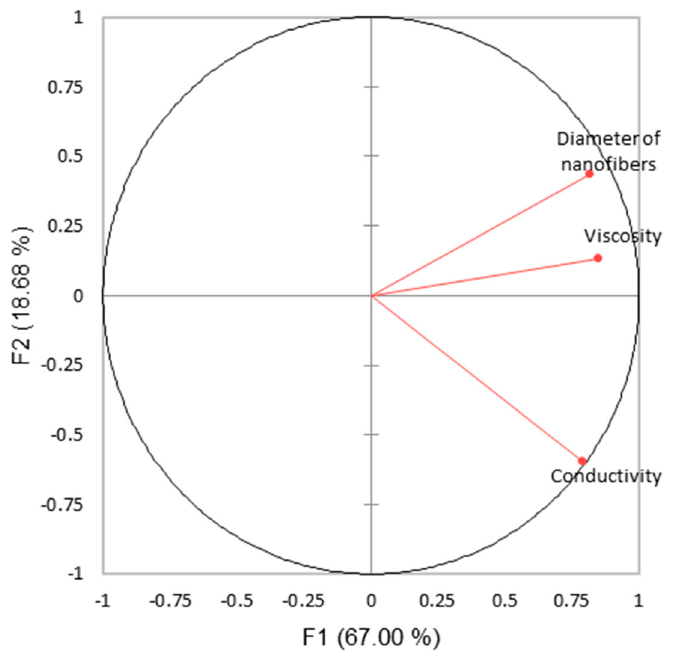
Figure 10. PCA biplot for the conductivity and viscosity of the emulsions and the diameter of the nanofibers.